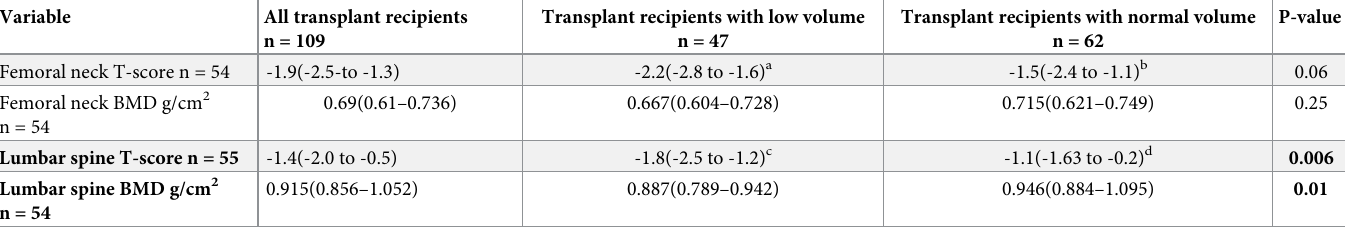
Values are expressed as median + interquartile range (in parentheses). a n = 28; b n = 26; c n = 29; d n = 26. BMD, bone mineral